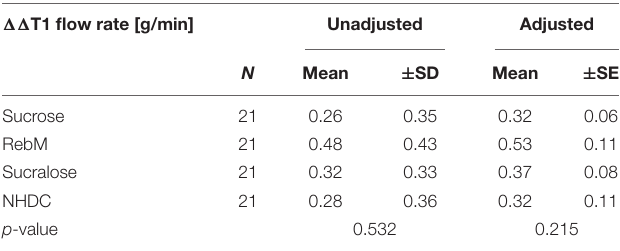
TABLE 3 | Unadjusted values and covariate-adjusted means ( ± SD/SE) of the normalized salivary flow rate (cid:49)(cid:49) T1 [g/min] = [(Tx T0)-(Tx-T0) H2O ] after stimulation with each test solution analyzed by means of an repeated measures ANCOVA with the basal level of α -amylase activity, cystatin S, pH, threshold, body height, body mass index (BMI), and age of participants as